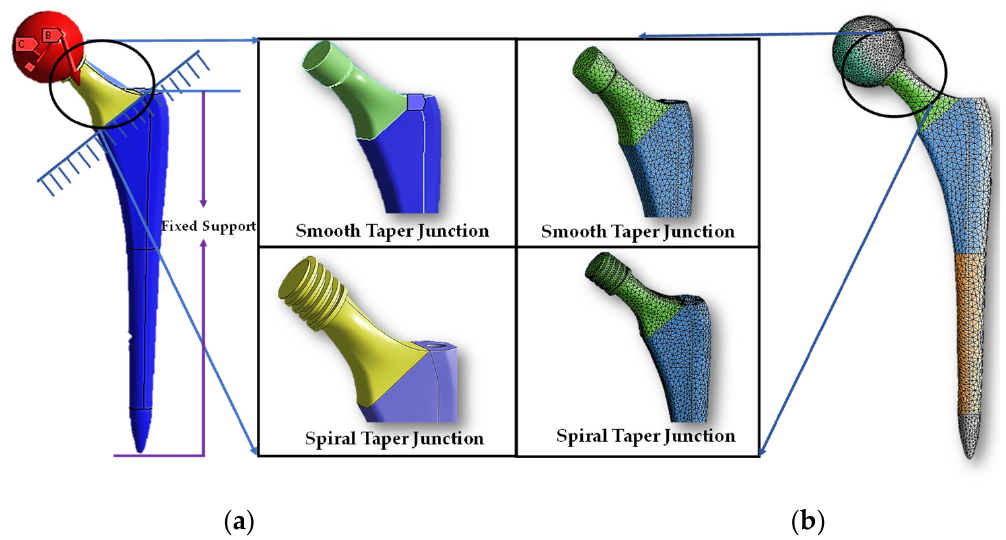
Figure 4. ( a ) Three-dimensional finite element model view in Ansys workbench interface and ( b ) meshing structure of a hip implant with smooth and spiral head-stem trunnions.